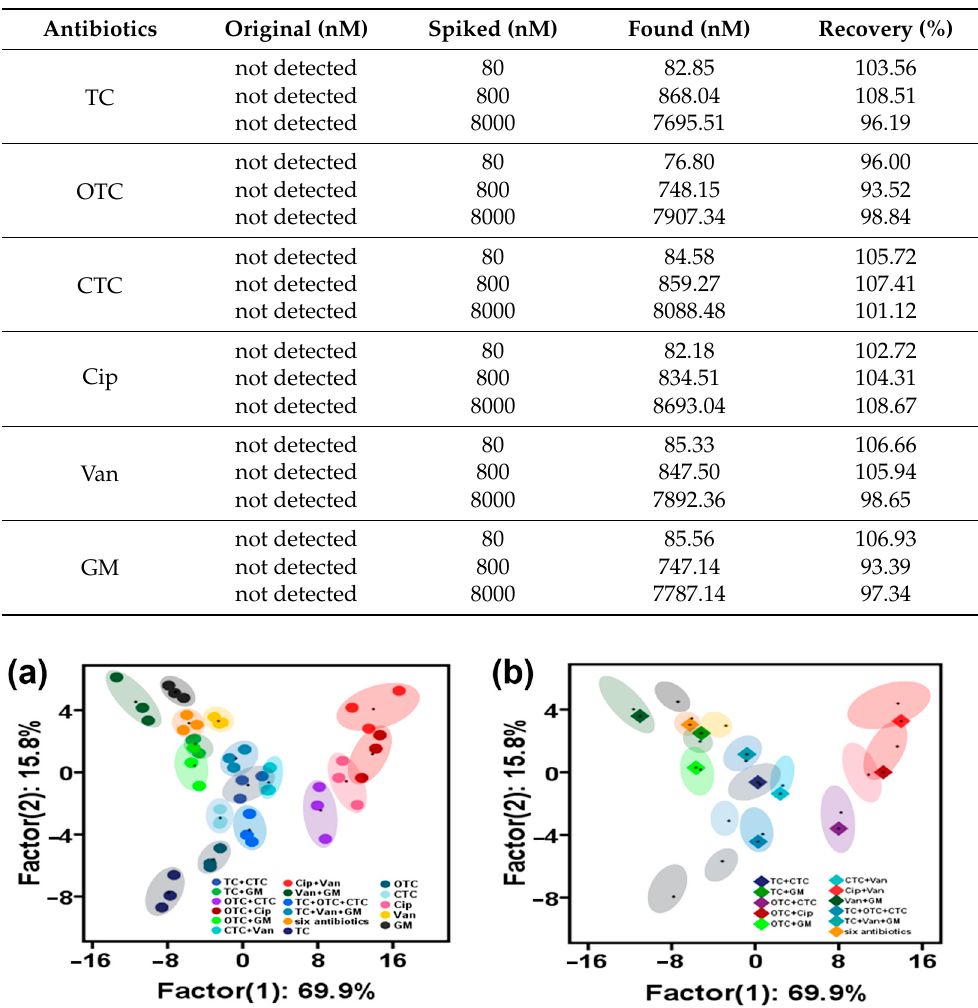
Table 1. Recovery results for antibiotic detection in river water. See Table S6 for detailed data.